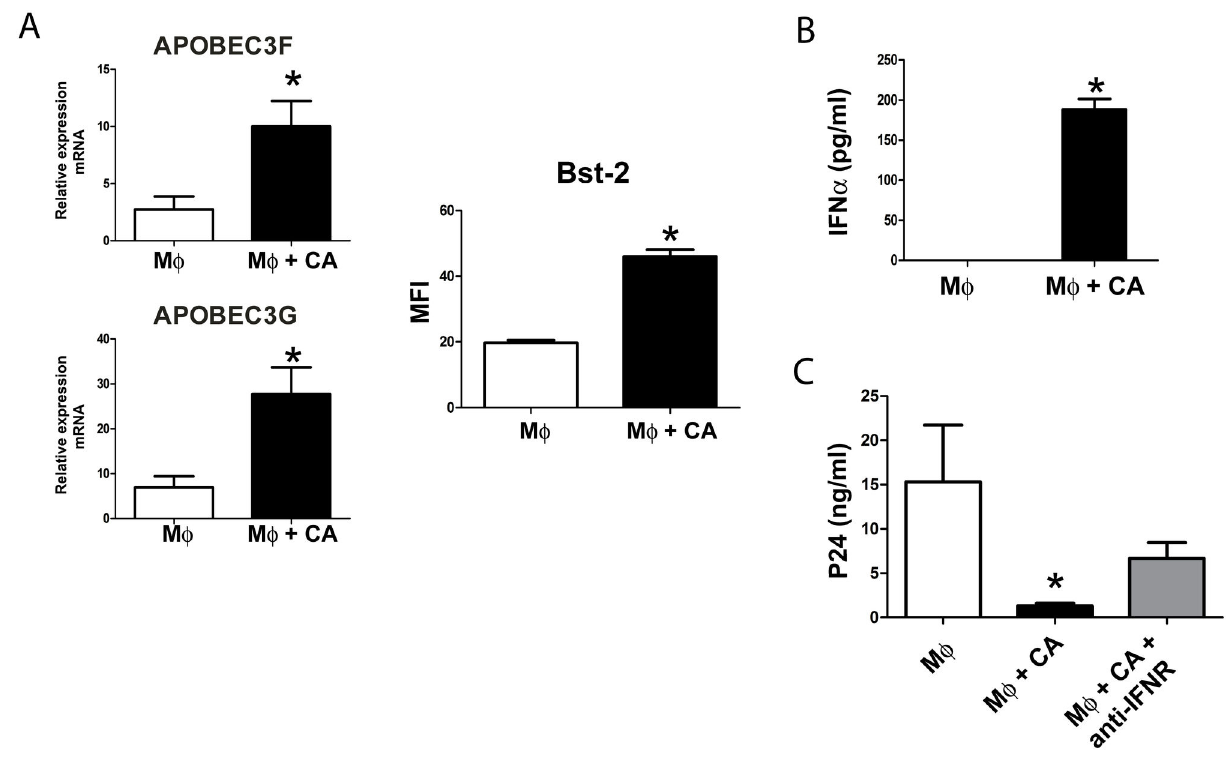
Figure 5. Candida albicans stimulates the production of the retroviral host-restriction factors APOBEC3G, APOBEC3F, tetherin, and interferon-α. ( A and B ) Macrophages (5x10 5 /0.5 ml) were cultured for 2 h in the absence or presence of CA using a macrophage: CA ratio of 1:10. Cells were then washed and cultured for an additional period of 18 h. Then, the presence of APOBEC3F and APOBEC3G was evaluated by quantitative PCR (relativized to the expression of GAPDH mRNA), the expression of tetherin (Bst-2) analyzed by flow cytometry, and the amount of IFN-α quantified in cell supernatants by ELISA. ( C ) Macrophages (5x10 5 /0.5 ml) were cultured with HIV-1 (50 ng p24/ml) in the absence or presence of CA (macrophage: CA ratio of 1:10). Then, BaL cells were washed and incubated with or without saturating concentrations of a blocking monoclonal antibody directed to the receptor for type I IFNs. The production of HIV-1 was evaluated at day 7 post-infection. In ( A ), representative experiments are shown (4,5). Bars represent the arithmetic means ± SEM of 5 experiments. (A and B) *p<0.05 vs M. ( C ) *p<0.05 vs M or M+CA +anti-IFNR. doi: